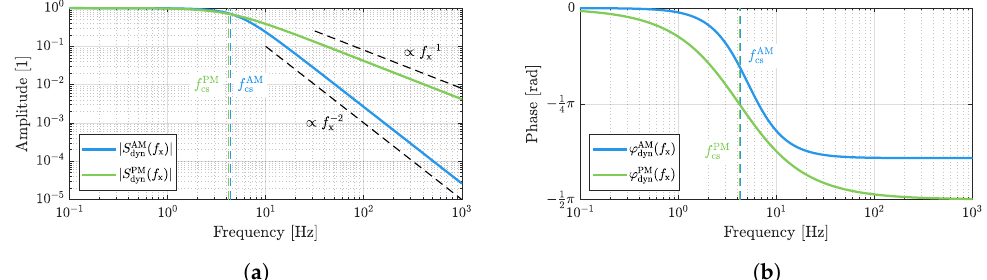
Figure 5. Illustrations of the dynamic sensitivities for amplitude mode and phase mode. The − 3dB cutoff frequencies are almost identical, whereas the slopes of the amplitude frequency responses